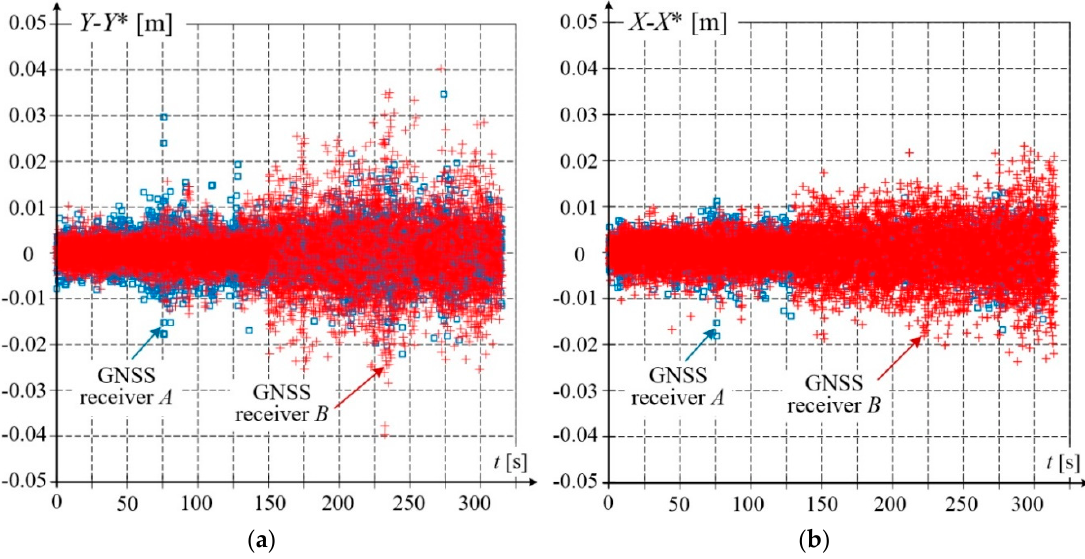
Figure 13. Results of filtration based on Savitzky–Golay and Whittaker algorithms calculated as differences of coordinates before and after filtration: ( a ) coordinate Y ; ( b ) coordinate X .